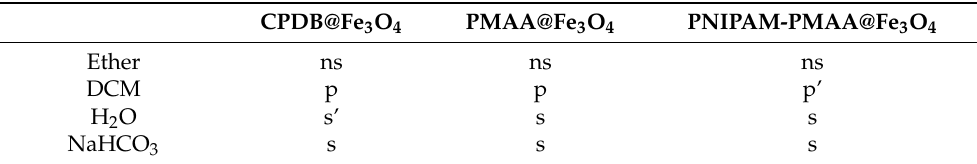
Table 2. Summary of particle suspension conditions in different solvents.